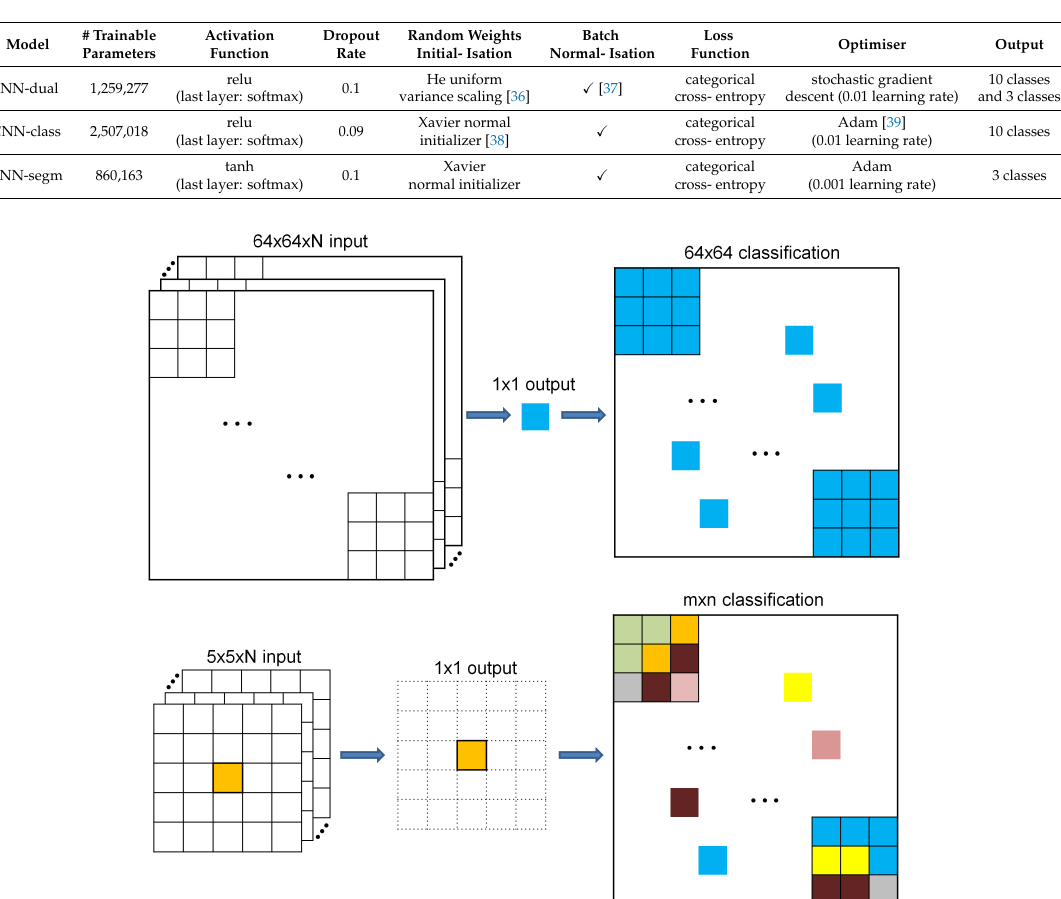
Figure 2. Input and output with respect to the CNN-class model ( top ) and both the CNN-segm and CNN-dual models ( bottom ). The variable N signifies the number of bands. The variables m and n denote the number of rows and columns, respectively, of the output